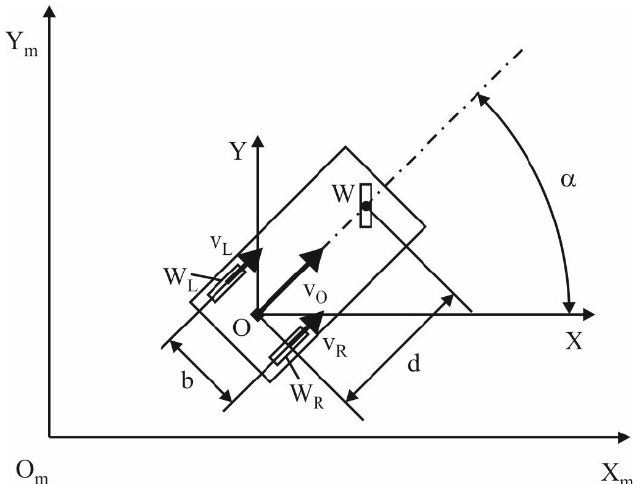
Figure 1. An AGV vehicle in the adopted coordinate system.